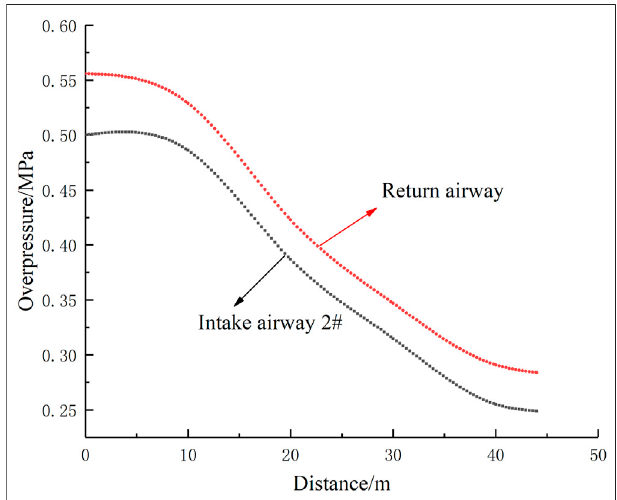
FIGURE8| Variationofpeakoverpressurewithdistanceinintakeairway 2 and return airway.